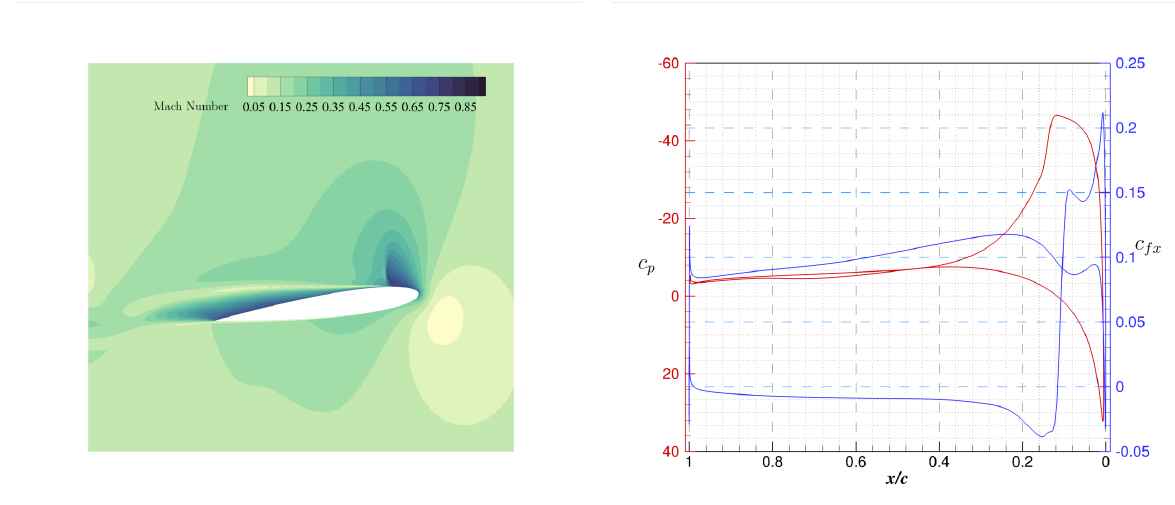
Figure 15. Mach contour of the slice r / R = 0.898 and the corresponding pressure coefficient c p , skin-friction in the x -direction c fx on the blade section, azimuth angle Ψ = 90 ◦ . On the upper surface, c fx drops from positive to negative and crosses 0 at x / c = 0.12, where the c p shows a sharp